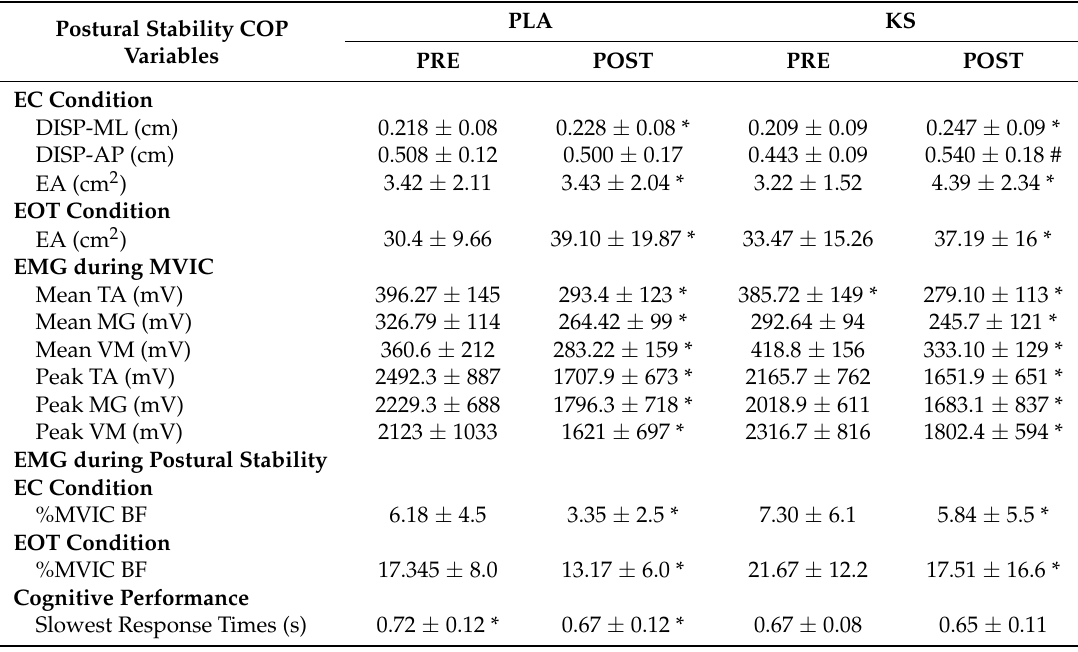
Table 2. Descriptive statistics for significant results.